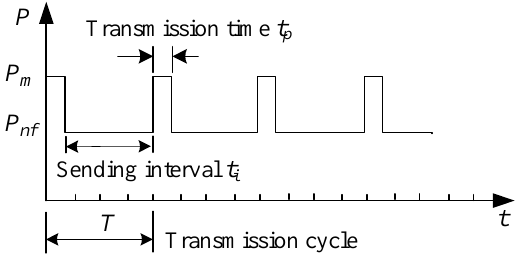
Figure 14. The relationship between transmission time and power consumption.